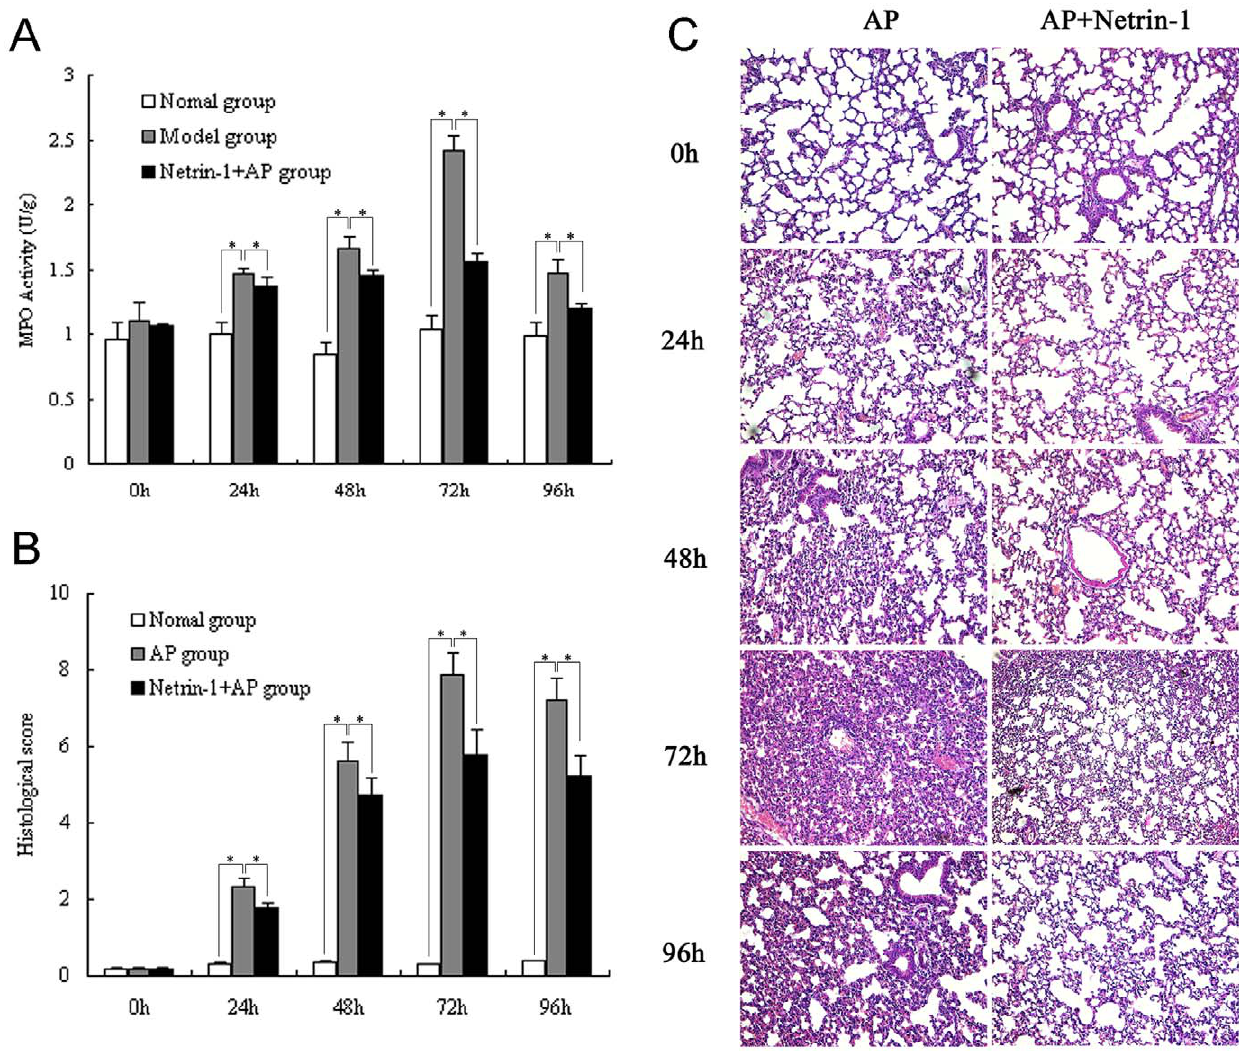
Figure 3. Effect of netrin-1 on lung MPO and histology. A. Lung myeloperoxidase (MPO) activity. B. Histological scores (sum of inflammatory cell infiltration, pulmonary edema, and hemorrhage). C. Histology. Representative micrographs of H&E-stained lung sections at the indicated times are shown. Acute pancreatitis was induced by two intraperitoneal injections of L-Arginine (4 g/kg, 1 h apart). Mice were treated with recombinant mouse netrin-1 at a dose of 1 m g/mouse or vehicle (0.1% BSA) immediately after the second injection of L-Arginine and every 24 h thereafter. Data are presented as mean 6 SD (n=6 per group in the normal mice, n=8 per group in both the AP model and netrin-1 treated AP model). * P , 0.05.